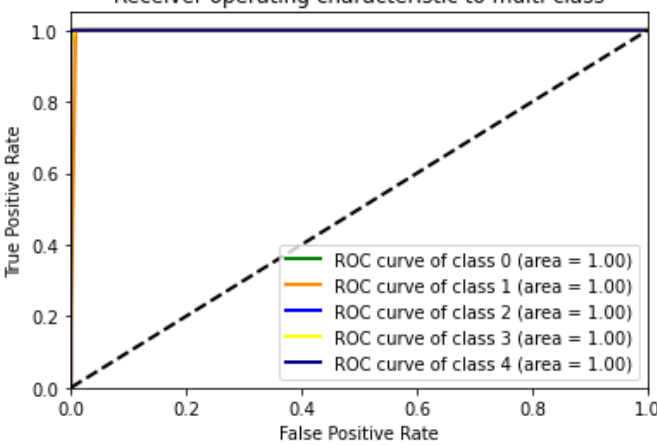
Figure 8. Receiver operating characteristics curve for 100 epochs.